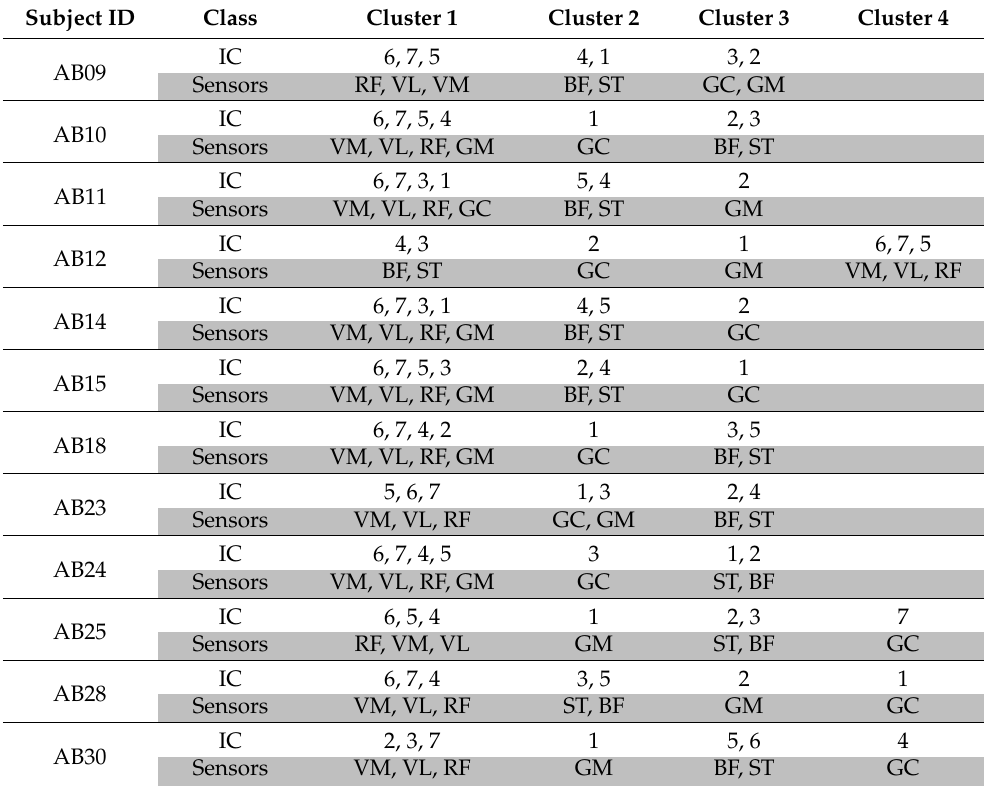
The shaded cells show the sensors corresponding to the independent